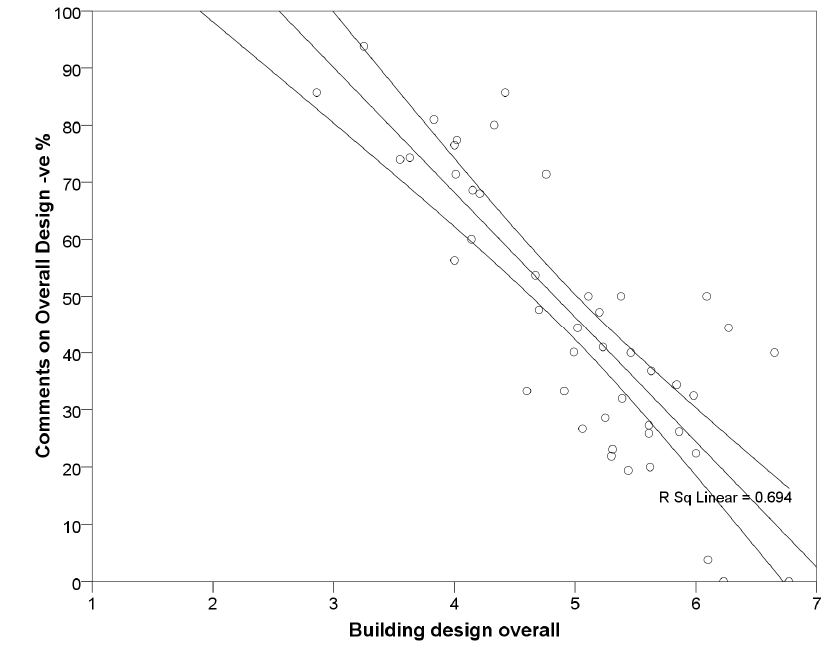
Figure 2. Graph of percentage of negative comments vs average scores for Overall